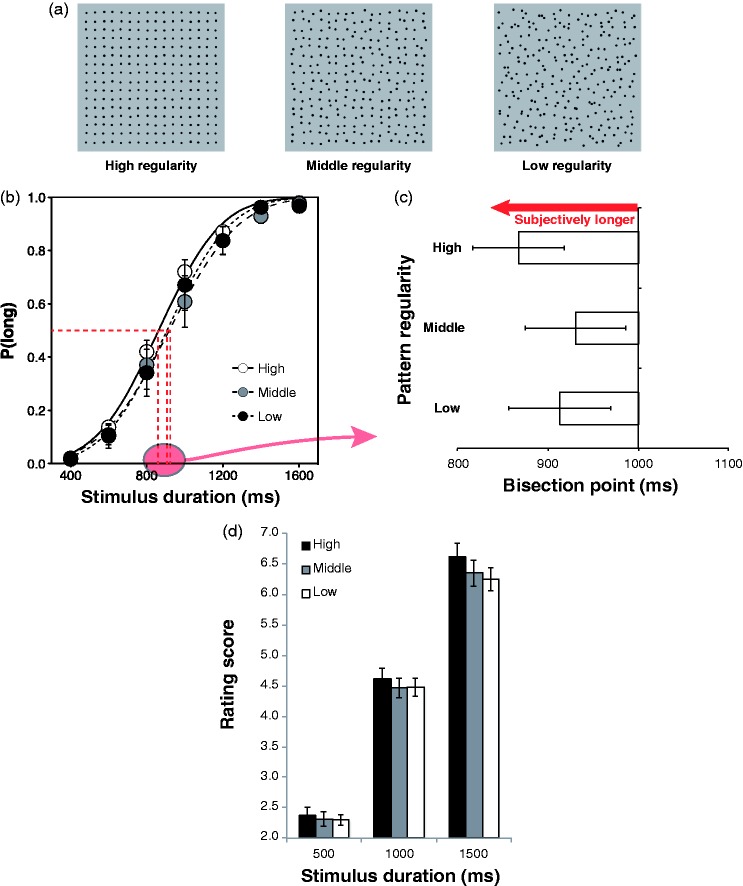
(a) Stimuli used in the experiment. (b) Proportions of long responses as a function
of stimulus duration for each level of regularity. Error bars denote the standard
errors of the mean. (c) Mean bisection points in each level of regularity. Error bars
denote the standard errors of the mean. (d) Mean rating score in each level of
regularity and each of stimulus duration. Error bars denote the standard errors of the
mean.